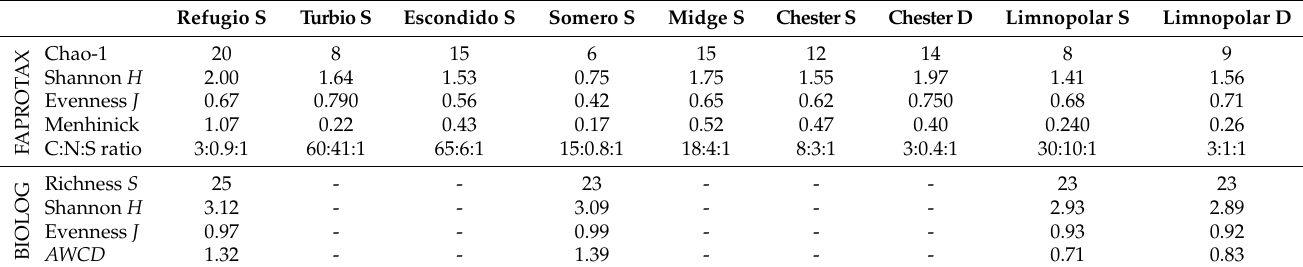
Table 2. Statistical and diversity parameters derived from the FAPROTAX and Biolog Ecoplates analyses. C:N:S ratios stand for the ratios among the number of activities related to the C, N, and S cycles in each sample. For the lake samples, S stands for surface samples, and D stands for deep (bottom)